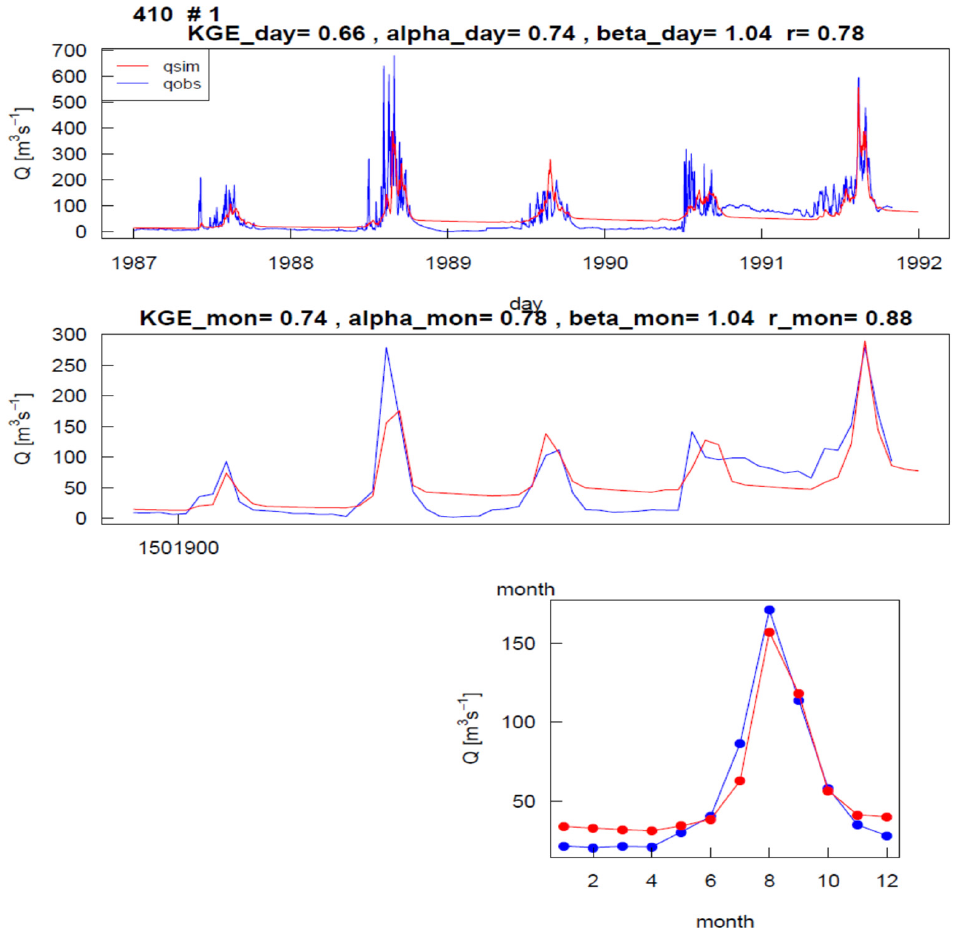
Figure 9. Hydrograph for Discharge Validation using mHM parameters from the independent model setup.